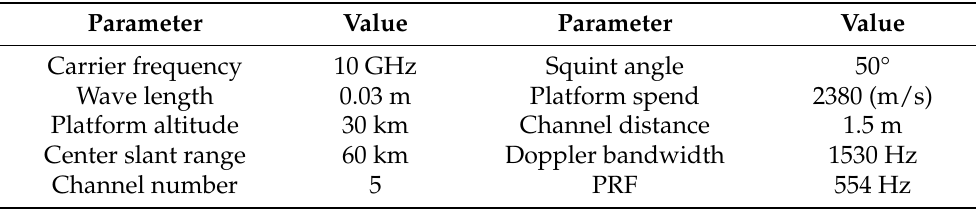
Table 2. Simulation parameters.